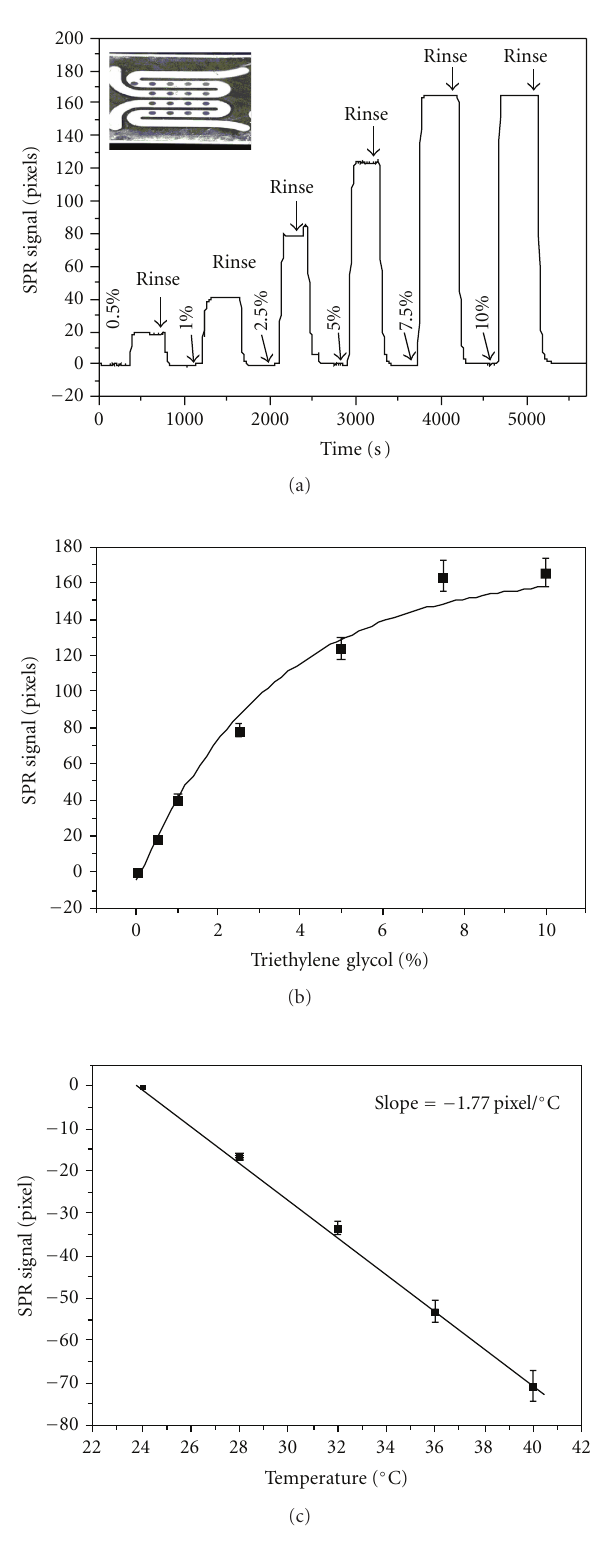
Figure 1: (a) SPRi signal over time for di ff erent percentages of triethylene glycol in ultrapure water at fixed temperature (27degrees). (b) Calibration curve of SPRi signal versus di ff erent percentage of triethylene glycol in ultrapure water. (c) SPRi signal versus temperature